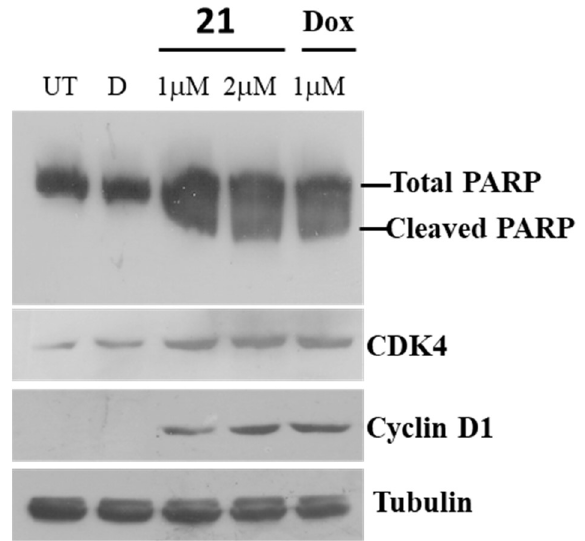
Figure 9. Immunoblot assay of barbatic acid ( 21 ). A549 cells were seeded and treated with 1 and 2 µM of 21 for 48 h. Subsequently, the cells were harvested, and lysates were subjected to immunoblot analysis. As a positive control, doxorubicin was employed at 1 µM concentration. UT represents untreated cells and D is DMSO, vehicle control. Antibodies were probed against cyclin D1 and CDK4 proteins and tubulin was used as a loading control.